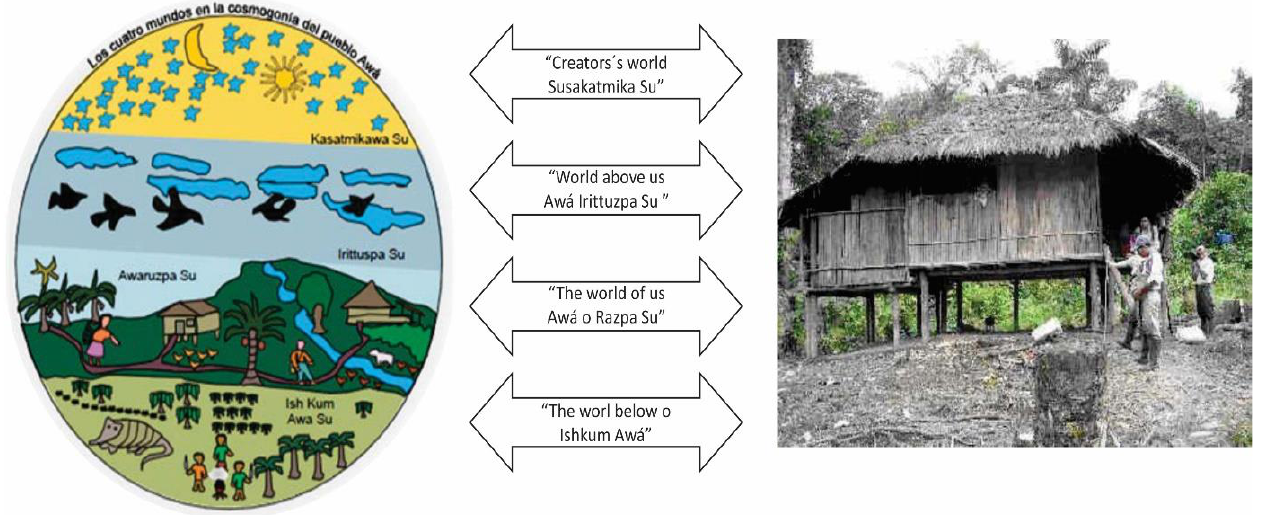
Figure 2. The “four worlds” of the Awá. (Source: Plan de Salvaguarda Étnico Awá, 2009. Photograph of a typical Awá house, courtesy of Camawari, 2010).